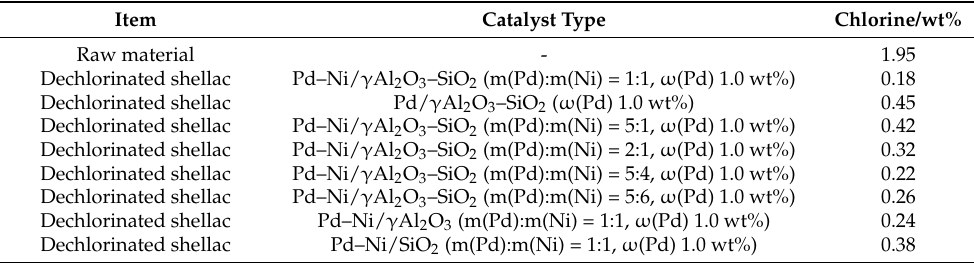
Table 2. Experimental results of catalytic HDC for shellac by the prepared